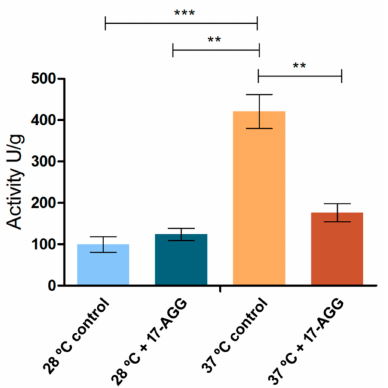
Figure 5. Evaluation of T. rubrum keratinolytic potential after growth in the presence or absence of the hsp90 inhibitor 17-AAG at 28 ◦ C or 37 ◦ C. Keratinolytic activity is calculated in unities / g (U / g). Data are means ± SD. Significant statistical di ff erences are represented by asterisks (** p < 0.01, *** p <